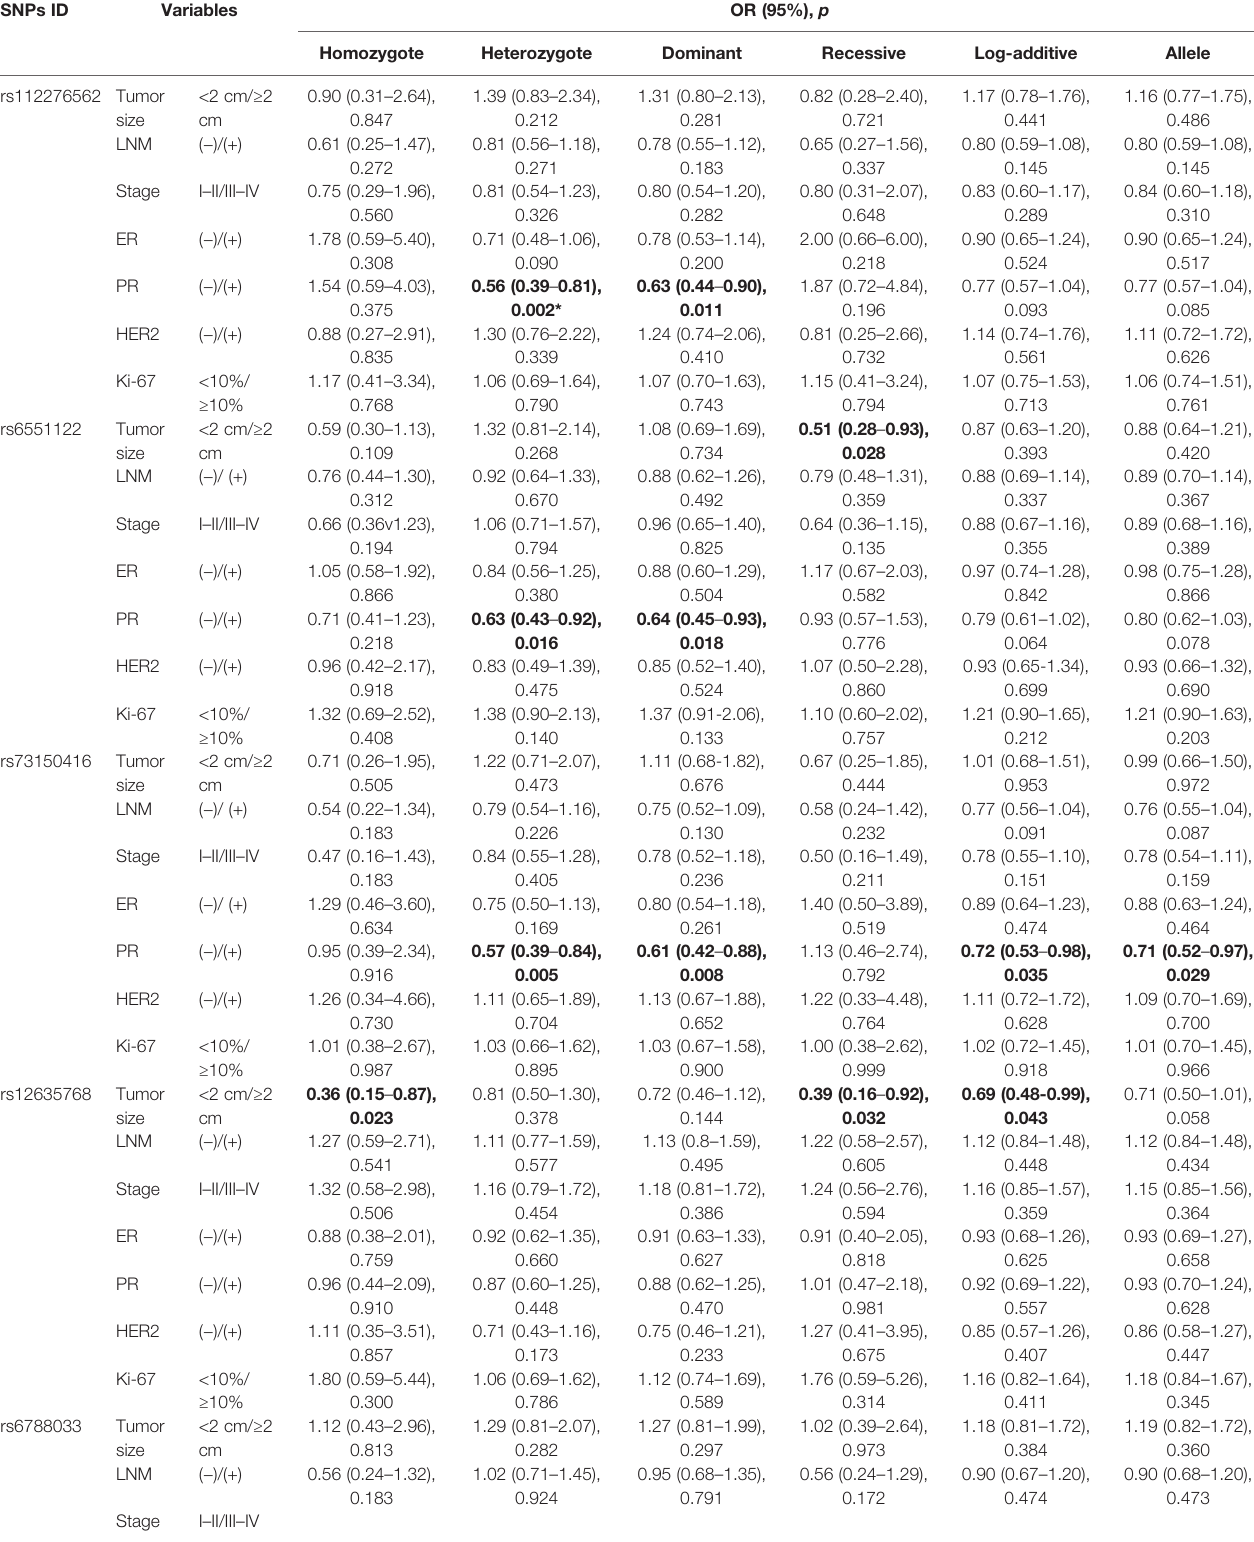
TABLE 4 | The association between LRRC3B polymorphisms and clinical features of breast